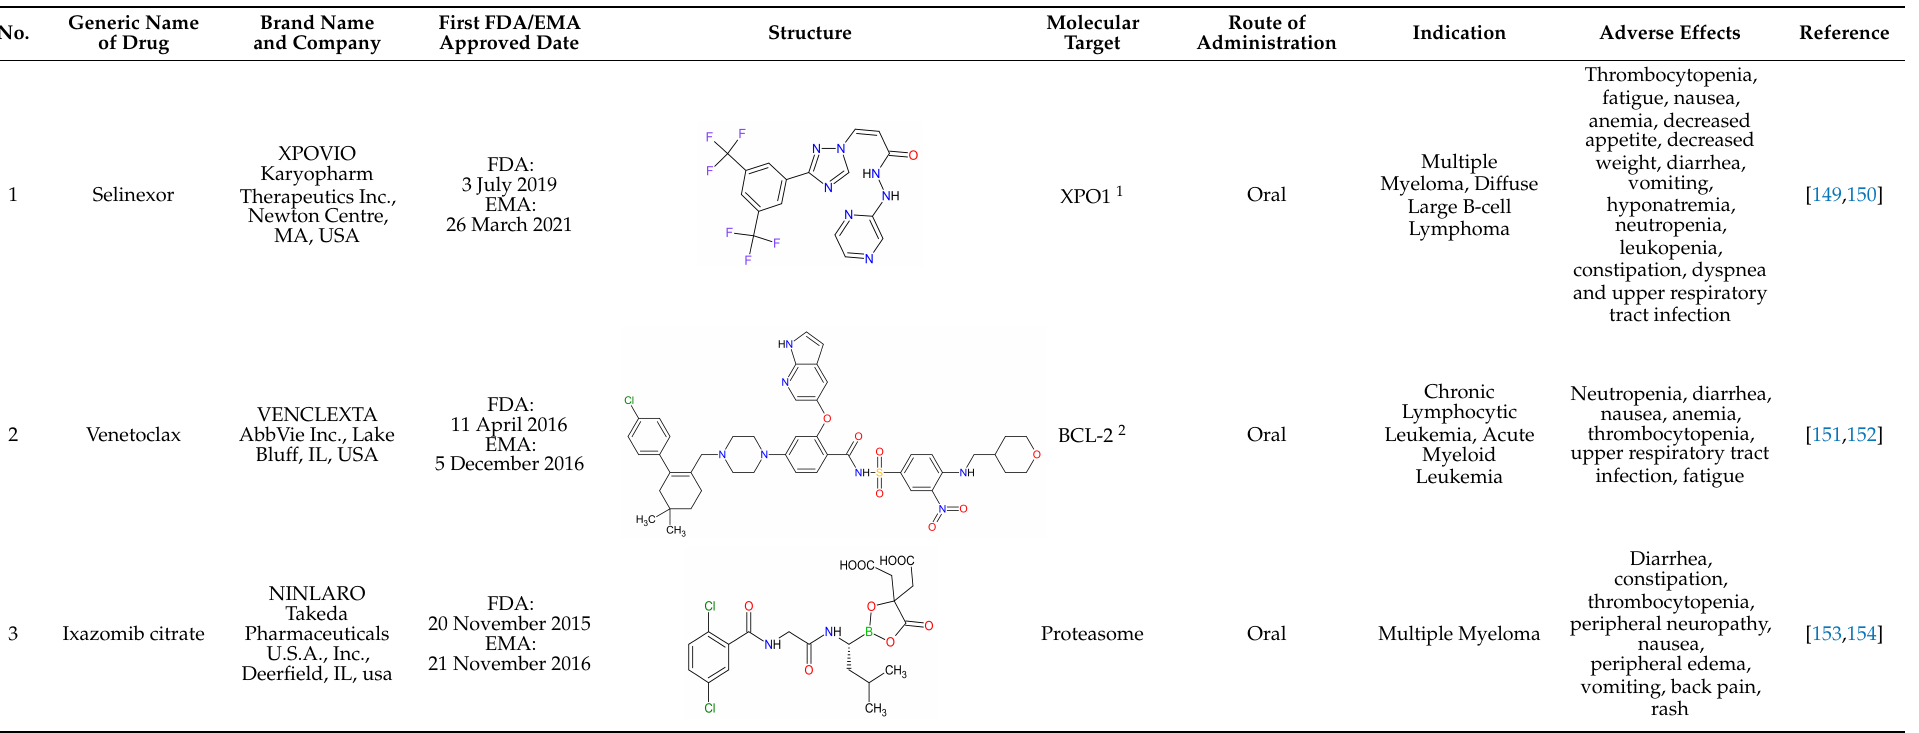
Table 6. Features of the various proteins inhibitors approved by the Food and Drug Administration (FDA) from 2011 to 2021. The order of drugs is tabulated in order of most recent to oldest registration